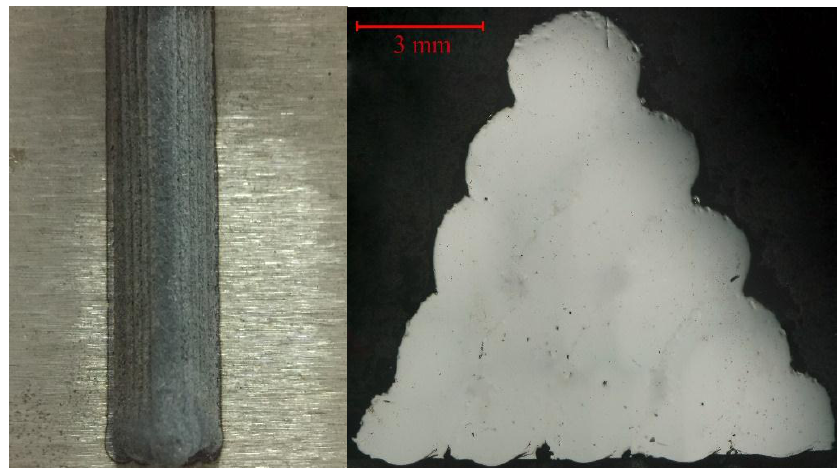
Figure 7 . Geometrical characteristics of two-dimensional gradient cladding ( left ) and cross-section of multi-track cladding layer ( right ).